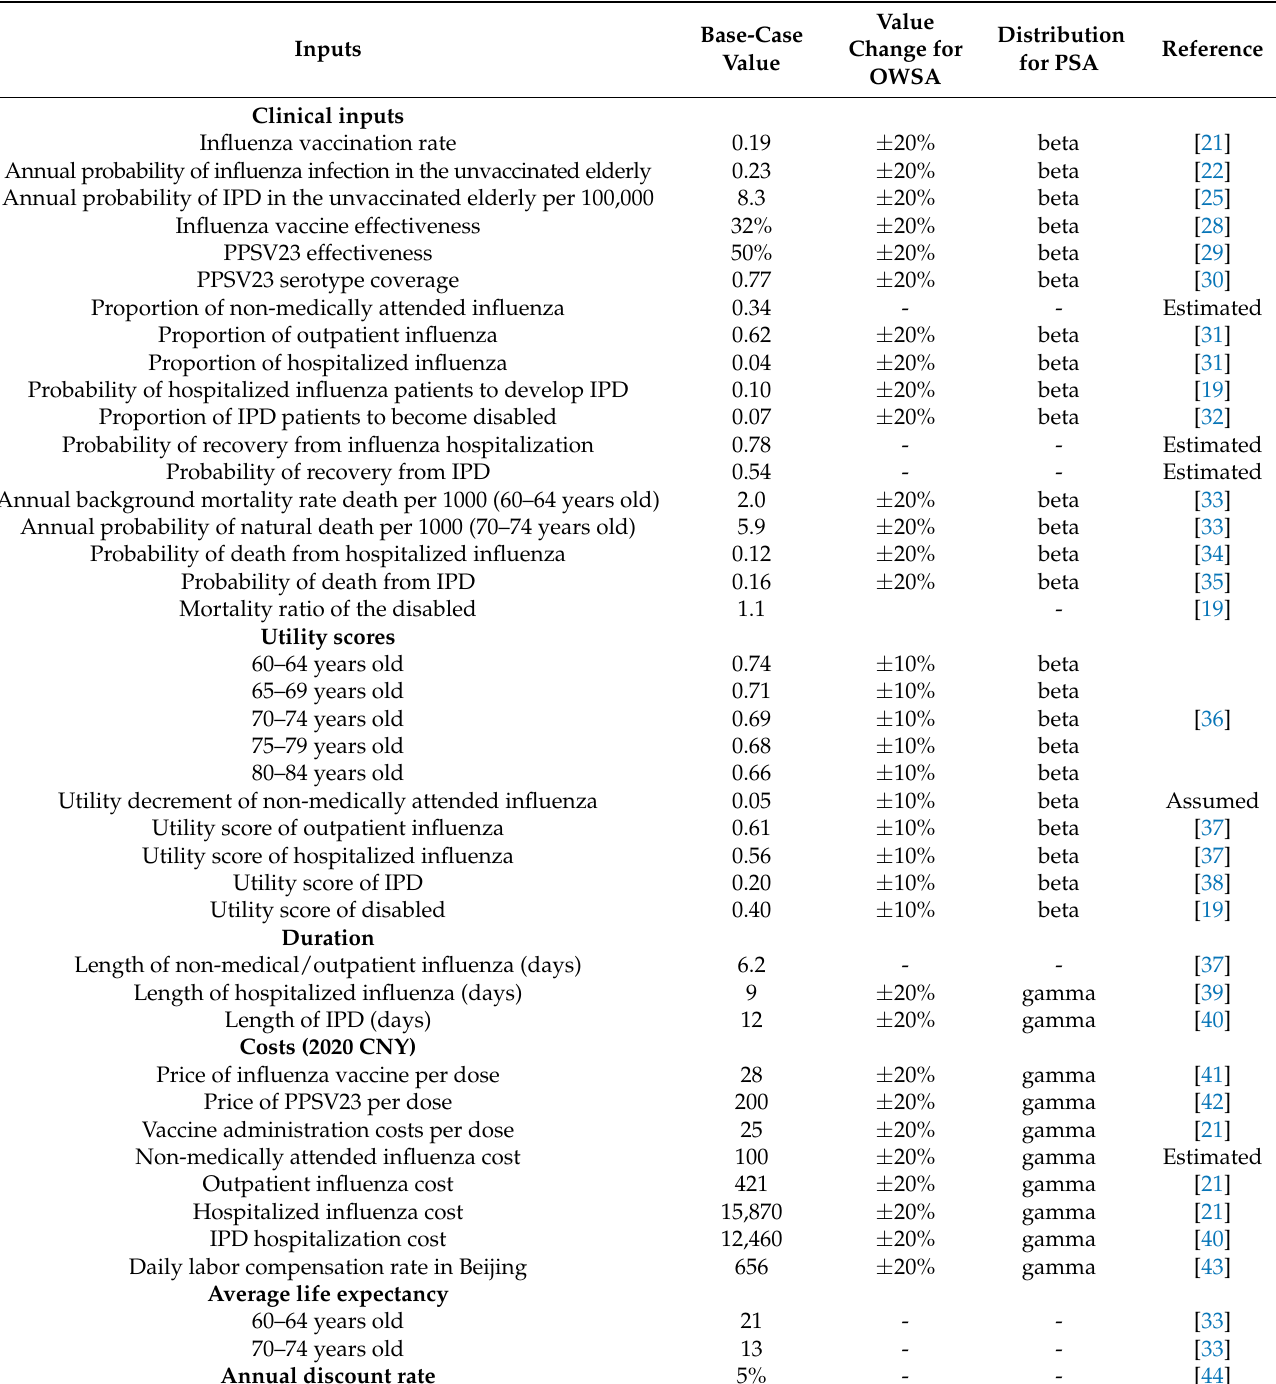
Table 1. Inputs of the Markov